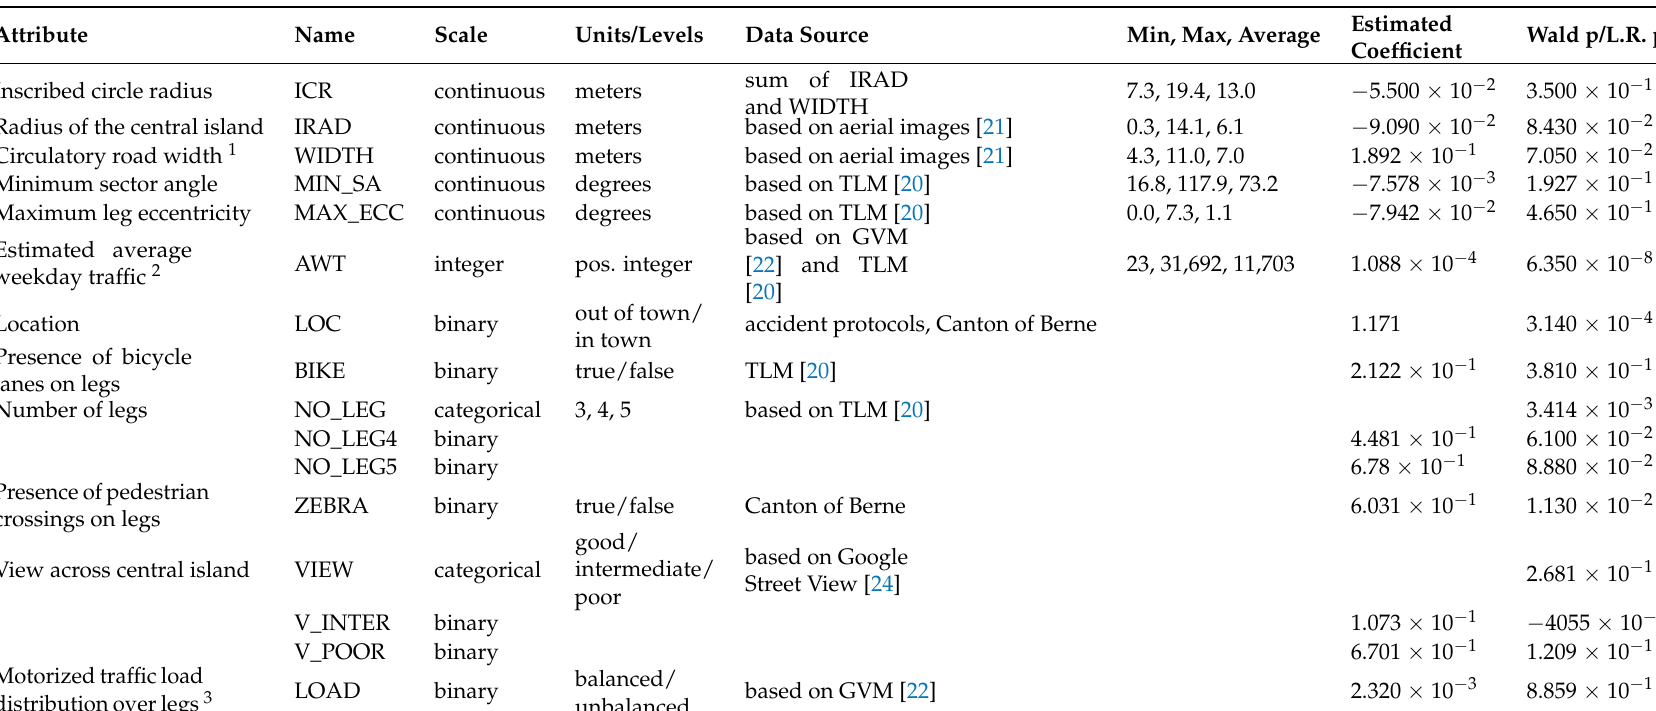
Table 1. List of attributes for single-lane roundabouts with 3–5 legs ( N = 294), with name [Name], data source from which the attribute was derived [Data Source], scale [Scale], units for continuous and levels for categorical variables [Units/Levels], and the minimum, maximum and average value for continuous attributes [Min, Max, Average]. The last two columns show results: the coefficient estimated in a univariate logistic regression [Estimated Coefficient] and its p -value for the Wald statistic or the log-likelihood ratio test for the significance of all levels of polytomous variables [Wald p /L.R. p